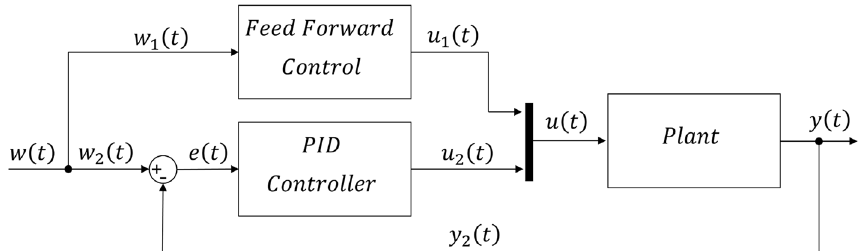
Fig. 3 Schema of the concept “decoupled PID controller” [own